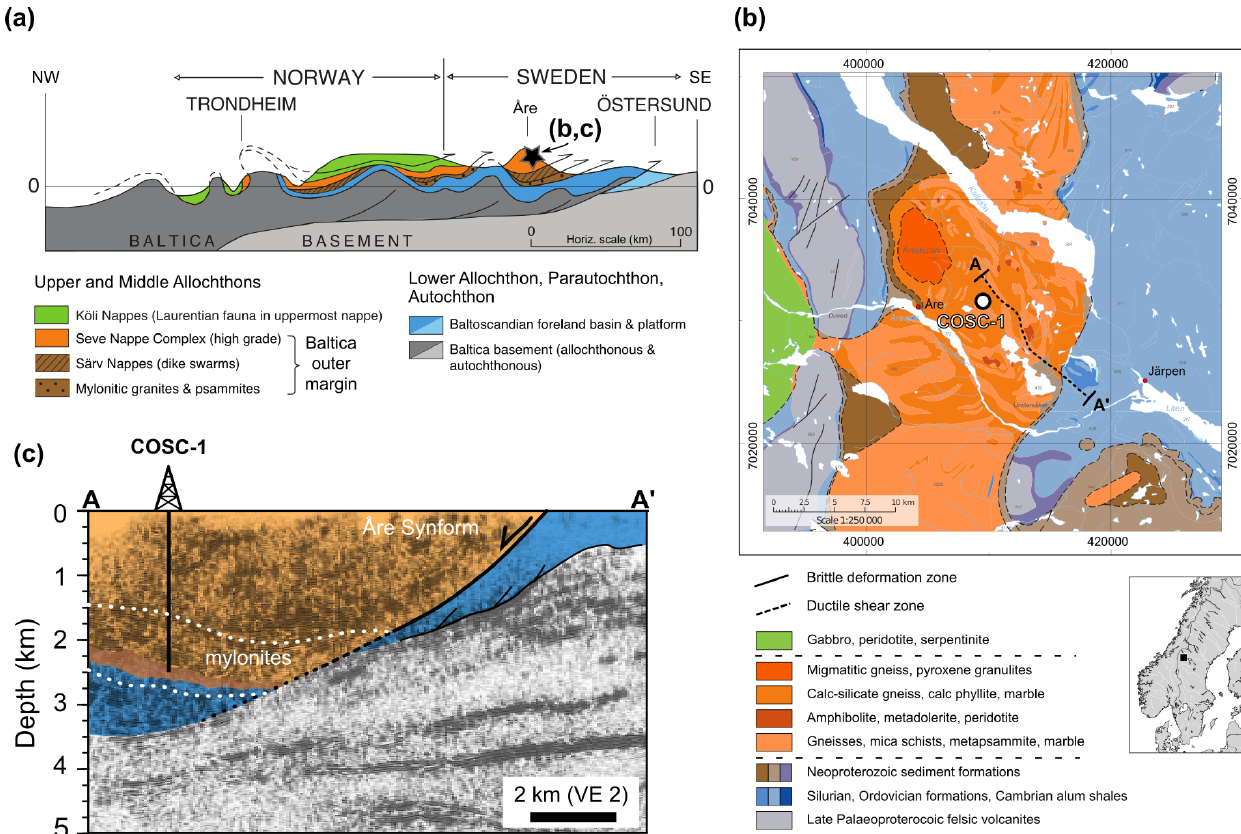
Figure 1. Overview of the regional setting and study area. (a) Tectonostratigraphic division of the central Scandinavian Caledonides (Gee et al., 2010; Lorenz et al., 2015a); (b) bedrock map with location of the COSC-1 borehole (colors modified; SGU Map Service; Strömberg et al., 1994); (c) seismic cross section indicated in (b) showing a part of the COSC seismic profile (Hedin et al., 2012) with the COSC-1 borehole penetrating the highly reflective Lower Seve Nappe (adapted from Juhlin et al.,